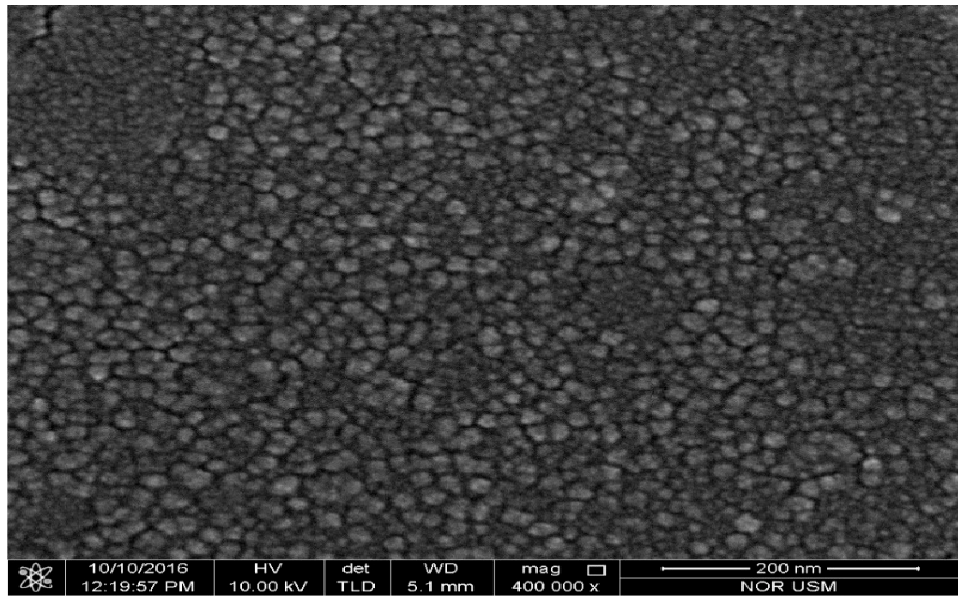
Figure 2. Surface morphology of MgB 4 O 7 :Zn glass observed by field emission scanning electron microscopy (FESEM).